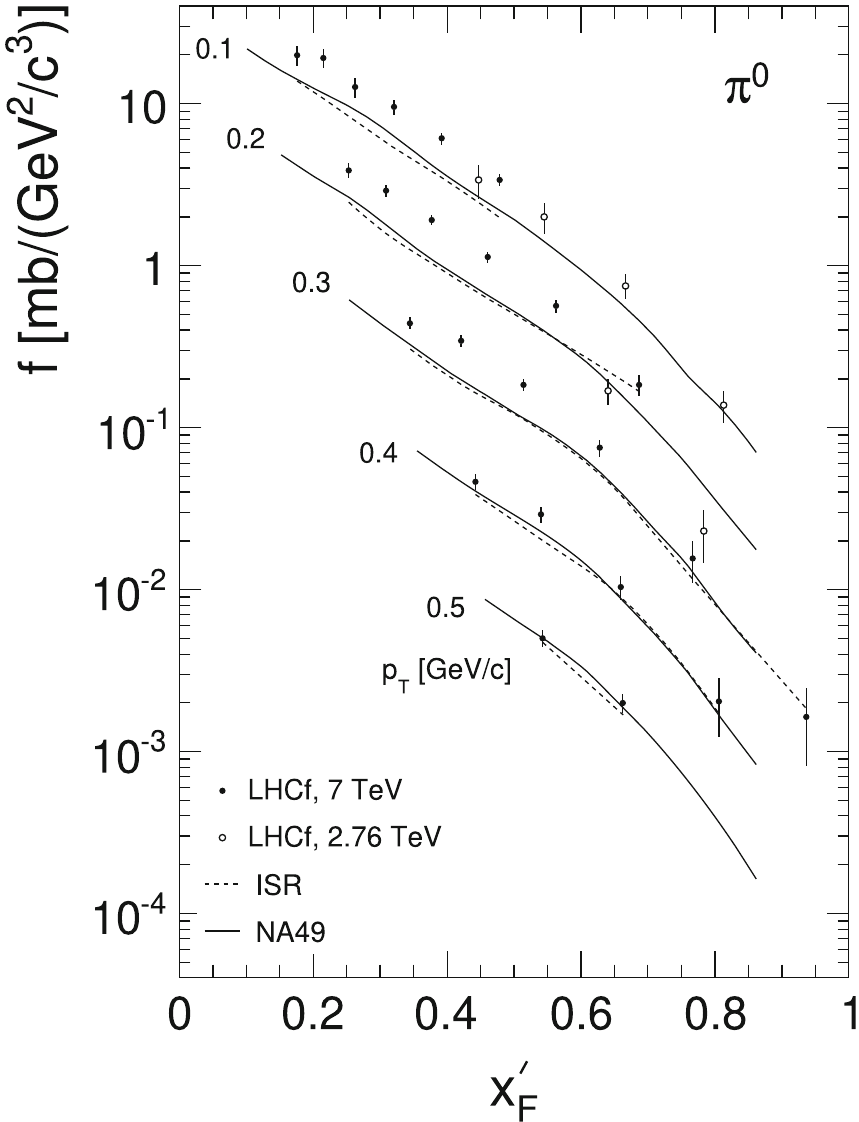
Fig. 120 Invariant π 0 cross sections f ( x (cid:3)